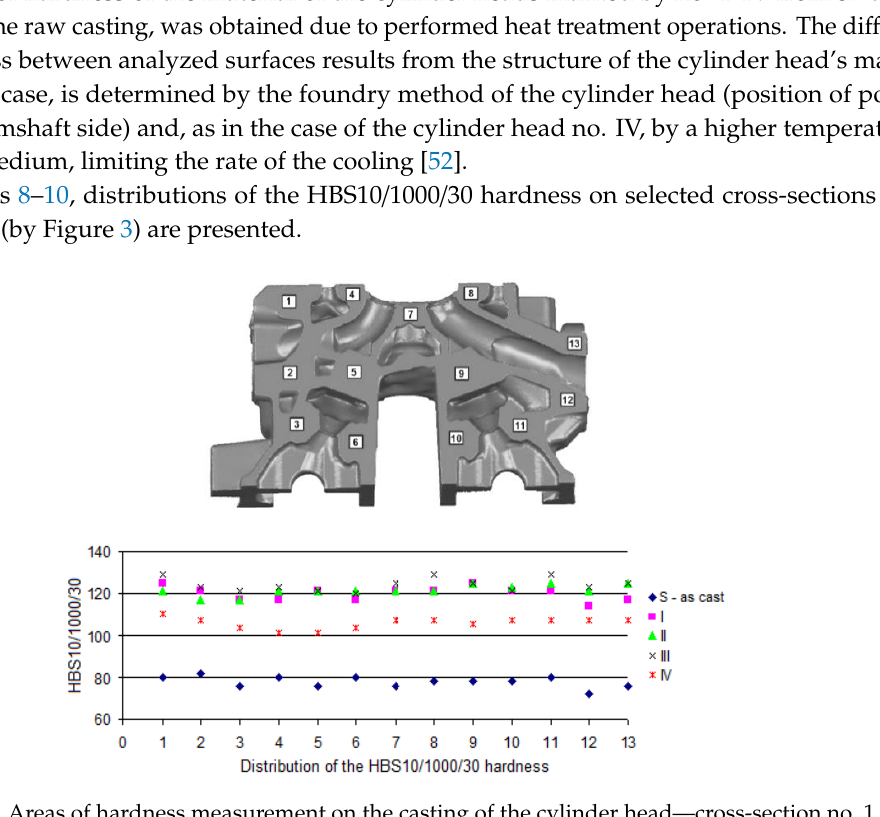
Figure 8. Areas of hardness measurement on the casting of the cylinder head—cross-section no. 1.